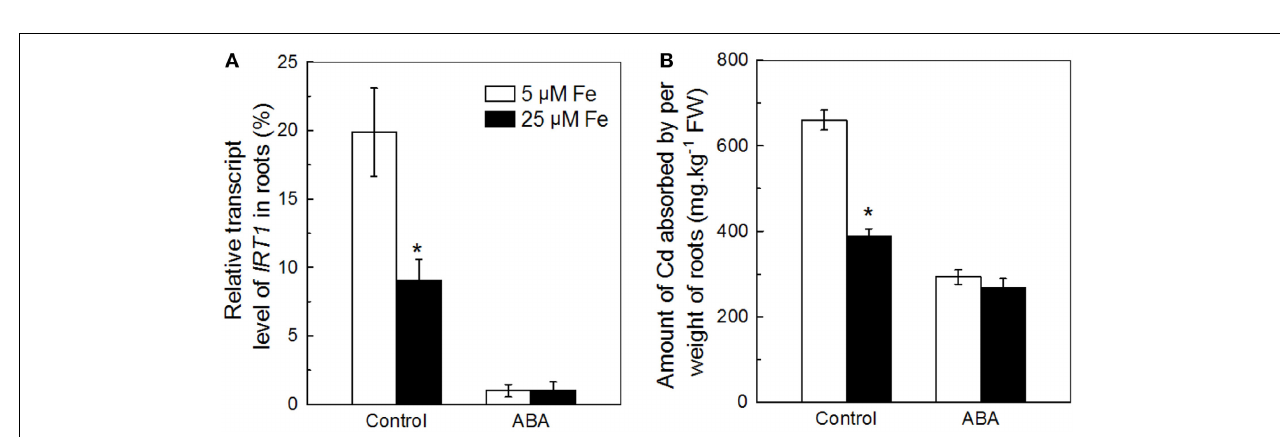
FIGURE 4 | Effect of ABA on Fe concentration in Col-0 plants and the irt1-1 and irt1-2 mutants. Plants were grown in 10 µ M Cd-added nutrient solution containing 0 ( − ABA) or 0.5 µ M ABA for 7 days. The Fe level in the